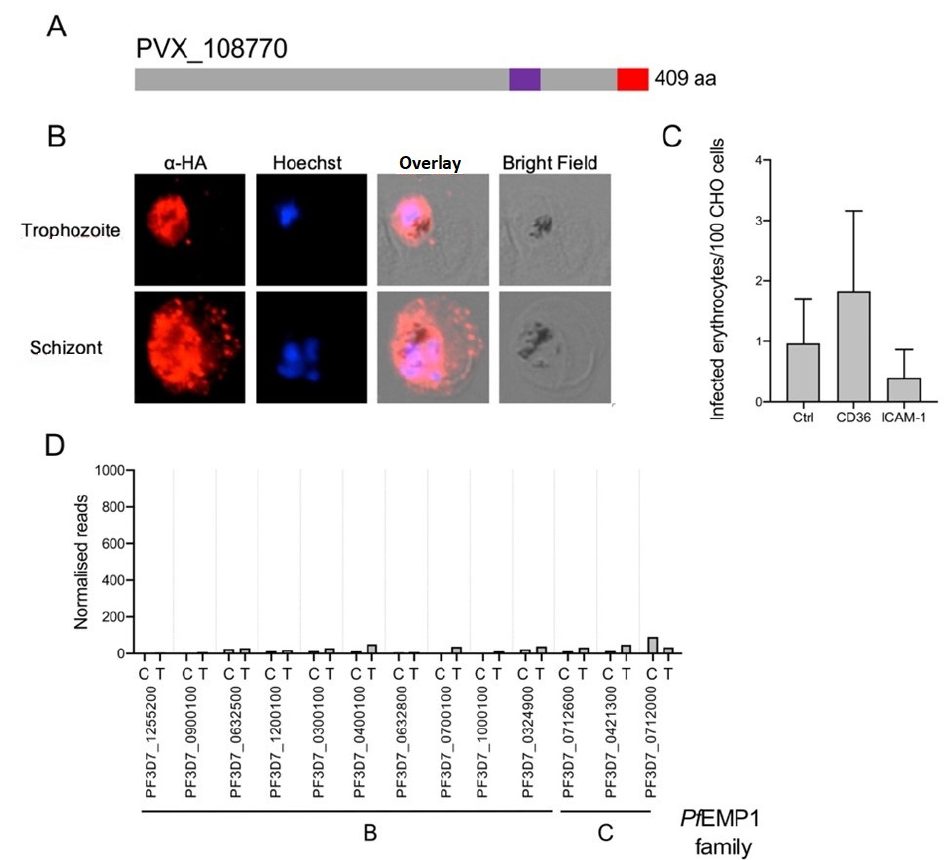
Figure 6. Characterization of PVX_108770 3D7 transfectants. ( A ) Schematic representation of VIR protein PVX_108770 (aa: amino acids, red: HA-tag, purple: putative transmembrane domain). ( B ) Lo-